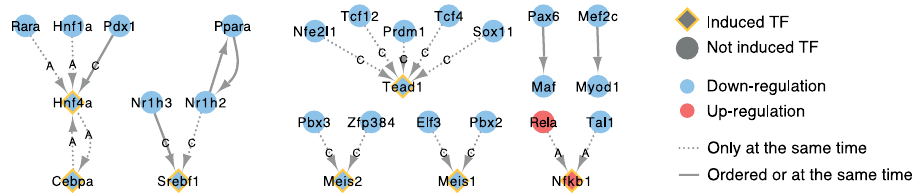
Fig 10. Causal relationships between TFs supported by time concordance. For TFs which are significantly enriched before or at adverse histopathology, known causal relations are shown in which the upstream event is found before or at the downstream event in at least 20% of adverse cases. For induced TFs for which expression is found before regulon activity and significantly enriched, not only protein-protein interactions are considered but also upstream TF-target gene interactions annotated with DoRothEA [69] confidence scores (A: High confidence, C: Medium confidence).